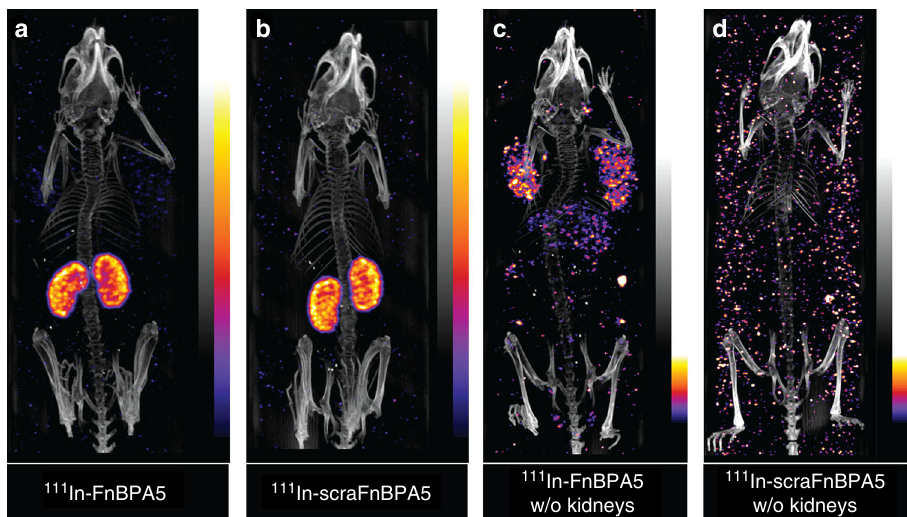
Fig. 5 SPECT/CT images of mice bearing PC-3 xenografts 96 h post injection. Mice were injected with 15 MBq 111 In-FnBPA5 a , c 111 In-scraFnBPA5 b , d , respectively. Images were acquired post mortem 96 h post injection. In a , b dominant kidney uptake of both 111 In-FnBPA5 and scrambled control peptide indicate unspeci fi c clearance via the kidney. To assess additional information on peptide distribution within the body, kidneys were removed c and d . In c uptake in tumors and liver for 111 In-FnBPA5 is shown, whereas the 111 In-scraFnBPA5 control does not show any speci fi c uptake in other organs. Results of SPECT/CT scans from individual sub fi gures are also shown in Supplementary Movies 1 – 4 showing 3D rotation movies of the respective